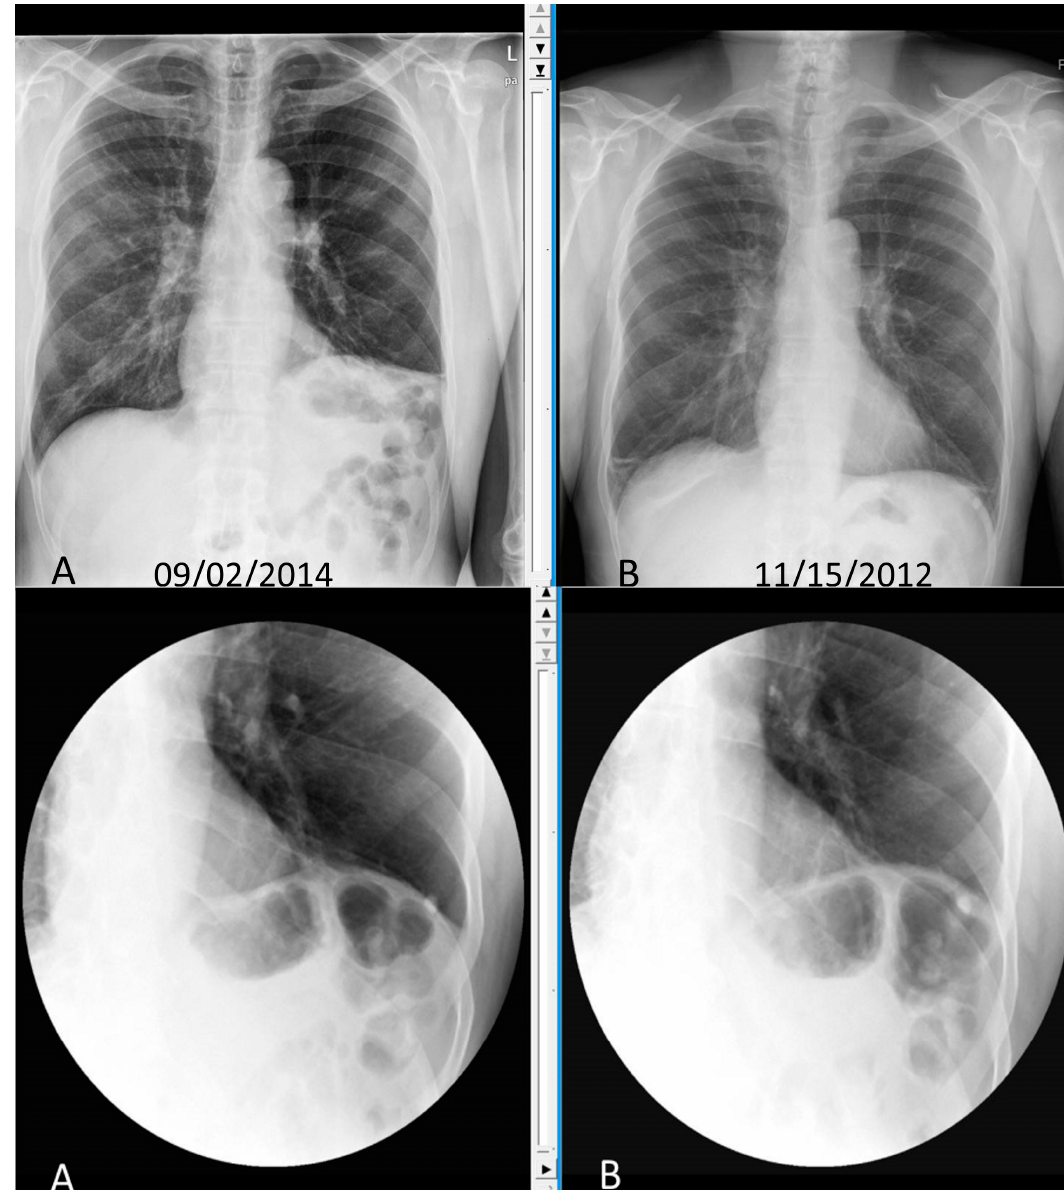
Figure 2. Chest X-ray and Static Sniff test of patient with cervical spondylosis leading to phrenic nerve compression and left diaphragmatic palsy. Top panel showing chest X-ray with elevated left diaphragm ( A ) compared to normal position on chest X-ray done 2 years back ( B ). Lower panel . Static Sniff test images in expiration ( A ) and after sniffing ( B ) showing no movement of diaphragm.